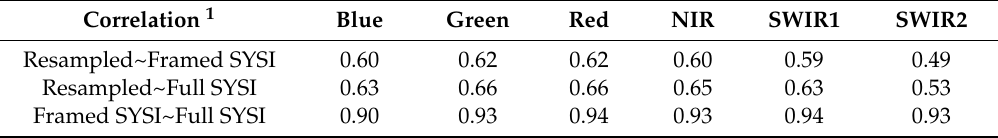
Table 2. Spearman correlation between laboratory resampled reflectance and synthetic soil images. Correlation 1